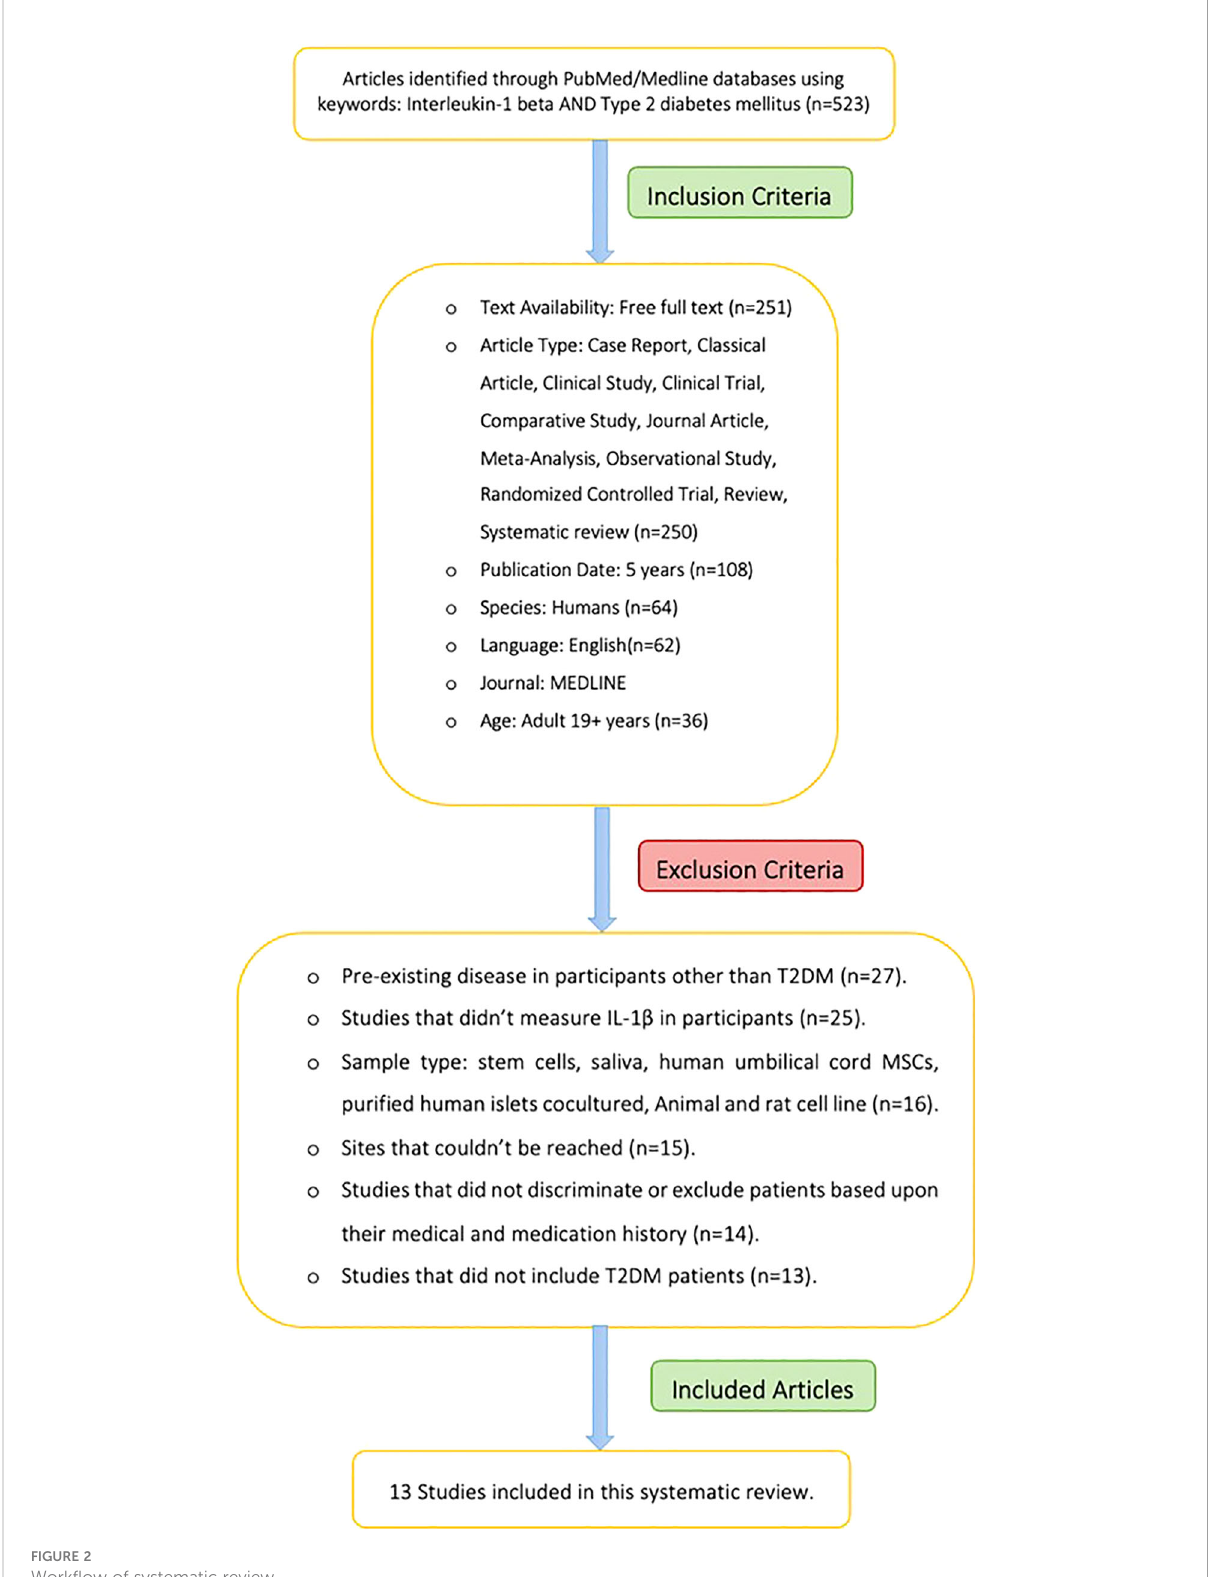
FIGURE 2 Work fl ow of systematic